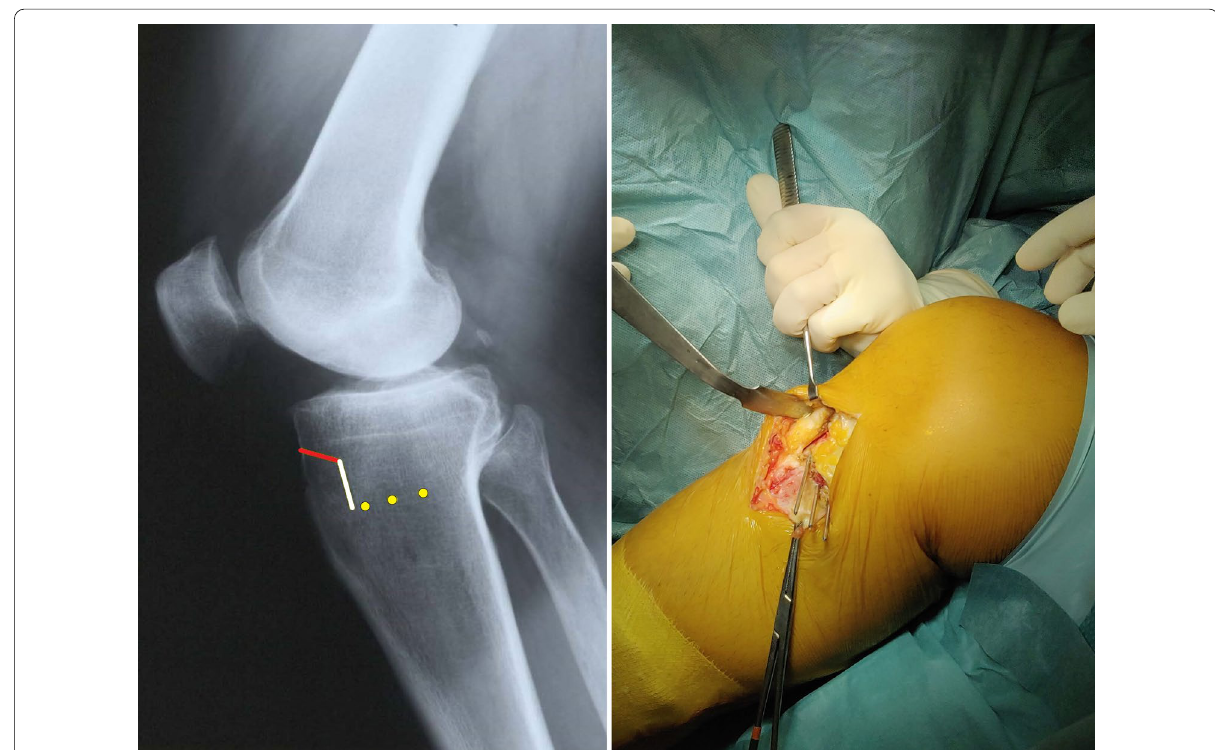
Fig. 5 On the left, a graphical representation of the three guide wires (yellow dots), the first coronal osteotomy (vertical white line) and the second osteotomy (red line) on an oblique plane, on a lateral X-ray view of a right knee. On the right, the intraoperative findings of the first two osteotomies, in a right tibia. The three wires are still positioned to guide the next last osteotomy